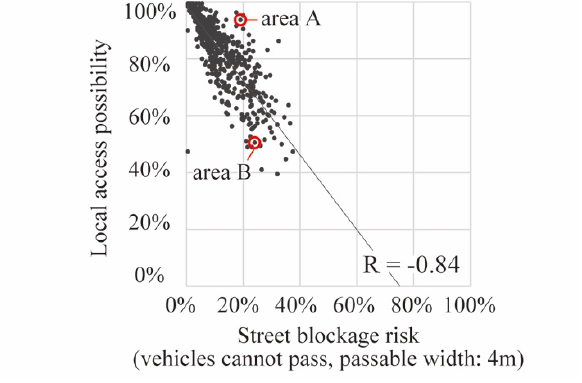
Figure 14. Comparison of street blockage risk and LAP